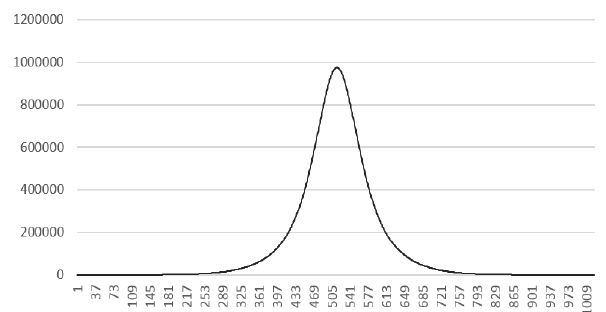
Fig. 7. The distribution of the values obtained by calculating the difference between two con- secutive